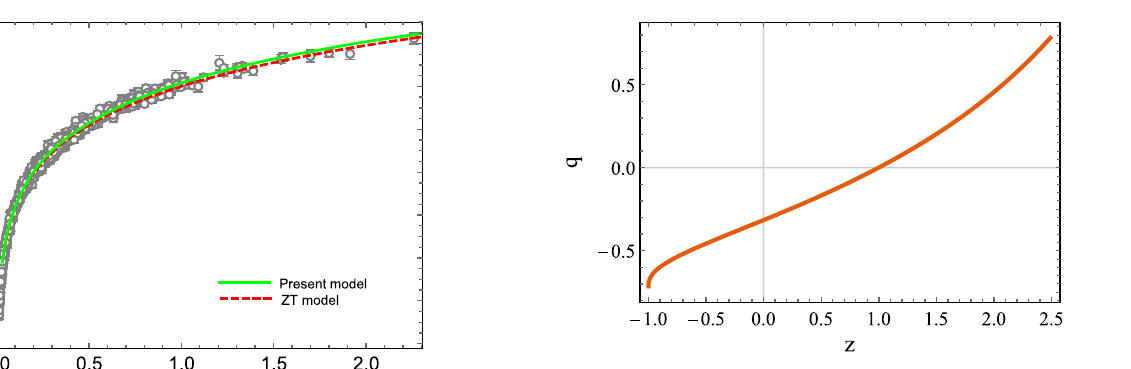
Fig. 9 Dependence of the deceleration parameter q with redshift z for the fitted values C d = 1 . 23, D d ,Δ = − 0 . 005, and d − Δ = 1. H 0 was set to be 67 . 4 (km/s)/Mpc. See Eq.